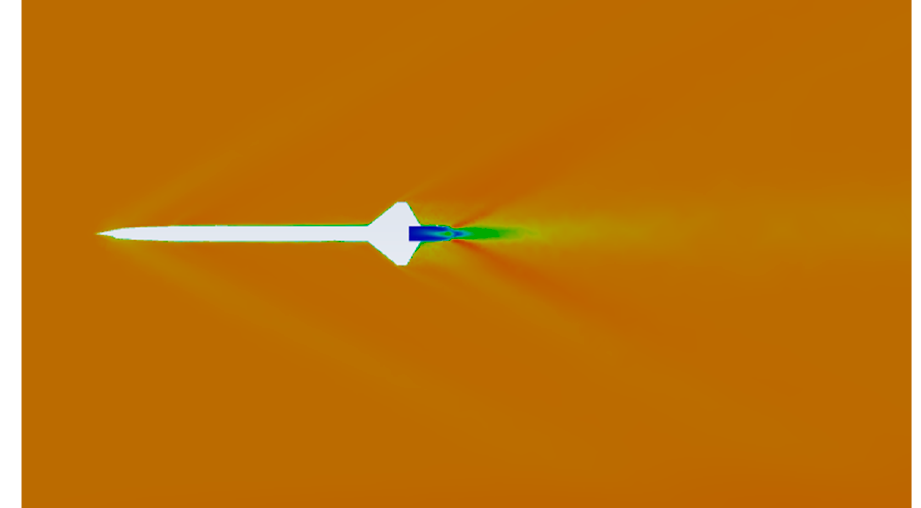
Figure 13. Mach number vs drag coefficient for an angle of attack of 2.4 degrees.